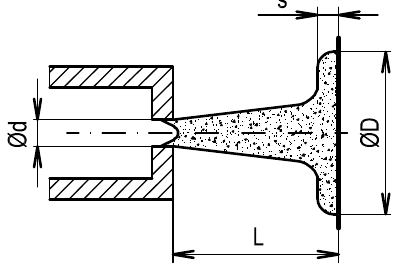
Fig. 6. Position of the orifice and